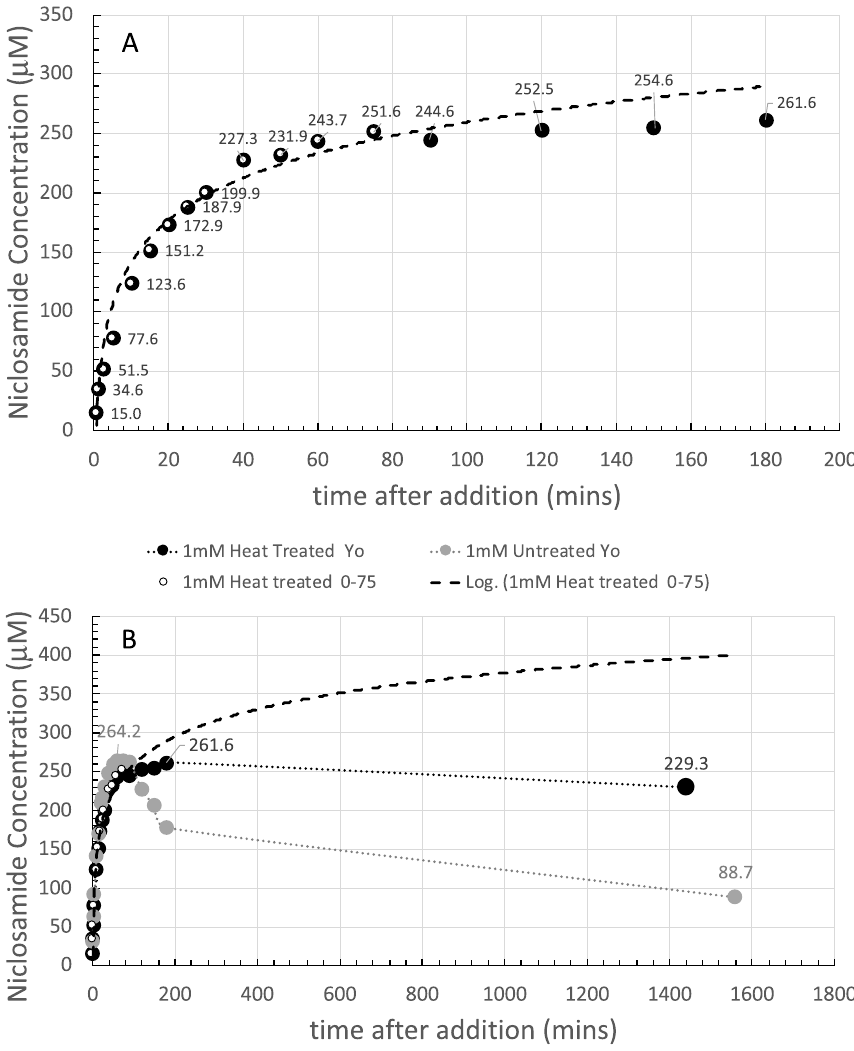
Fig. 8 Dissolution of ~1 mM 200 °C heat-treated Yomesan in nominal pH 9.35 Tris buffer at 23 °C: A 1 to 180 min, final pH 9.32 with logarithmic fit to initial data (dashed line); B comparison between heat-treated Yomesan (black-filled symbols) and untreated Yomesan (gray-filled symbols) from Fig. 4C in 9.35 TB vs time after addition out to day 2 final pH 9.26. Dotted lines are to guide the